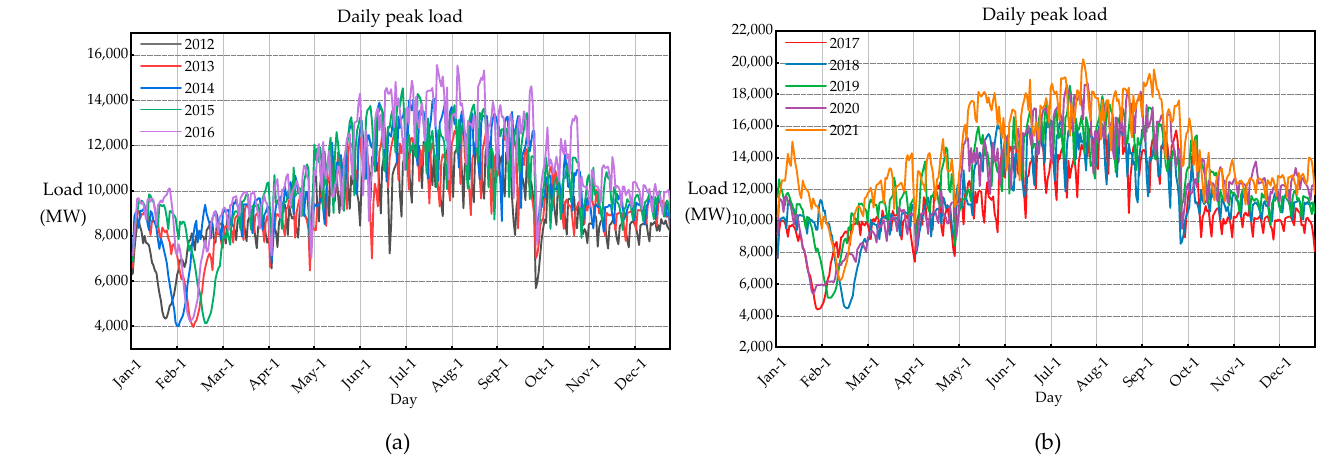
Figure 1. Daily peak load curves: ( a ) from 2012 to 2016; ( b ) from 2017 to 2021. We count the number of times the 3% peak load occurred in a year from 2012 to 2021. These loads are defined as loads that exceed 97% of the annual maximum load magnitude.